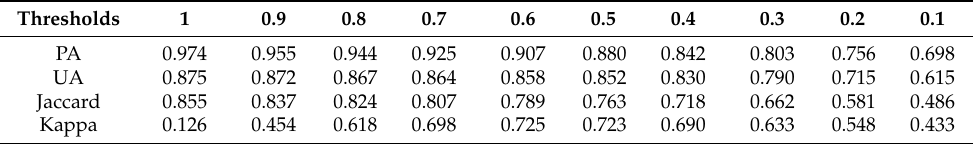
Table 5. Kudzu classification performance based on nonlinear unmixing after the phenology-based masking. Thresholds